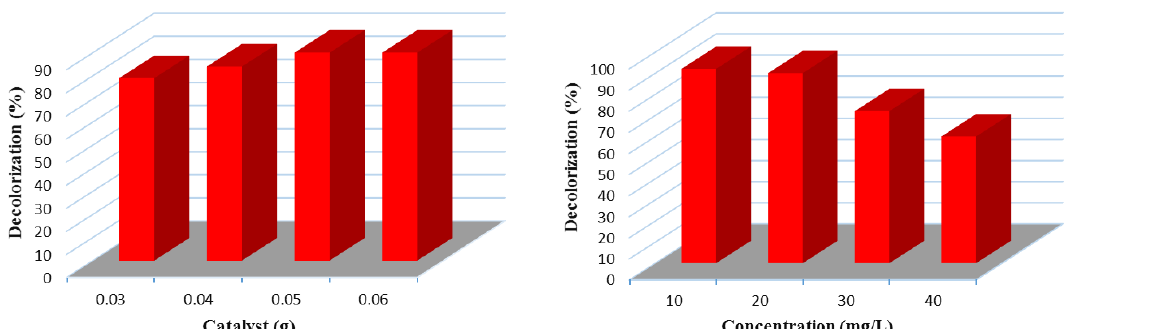
Fig. 6. The effect of visible light irradiation on the decolorization efficiency (%). Reaction conditions: Congo red =20 mg/L, catalyst= 0.05 g, pH=natural and room temperature.